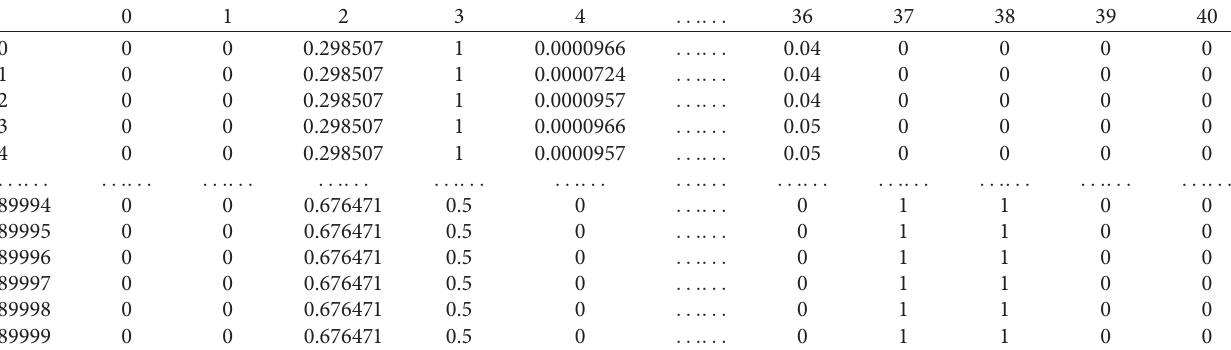
Table 2: KDD CUP 99 dataset normalization processing.